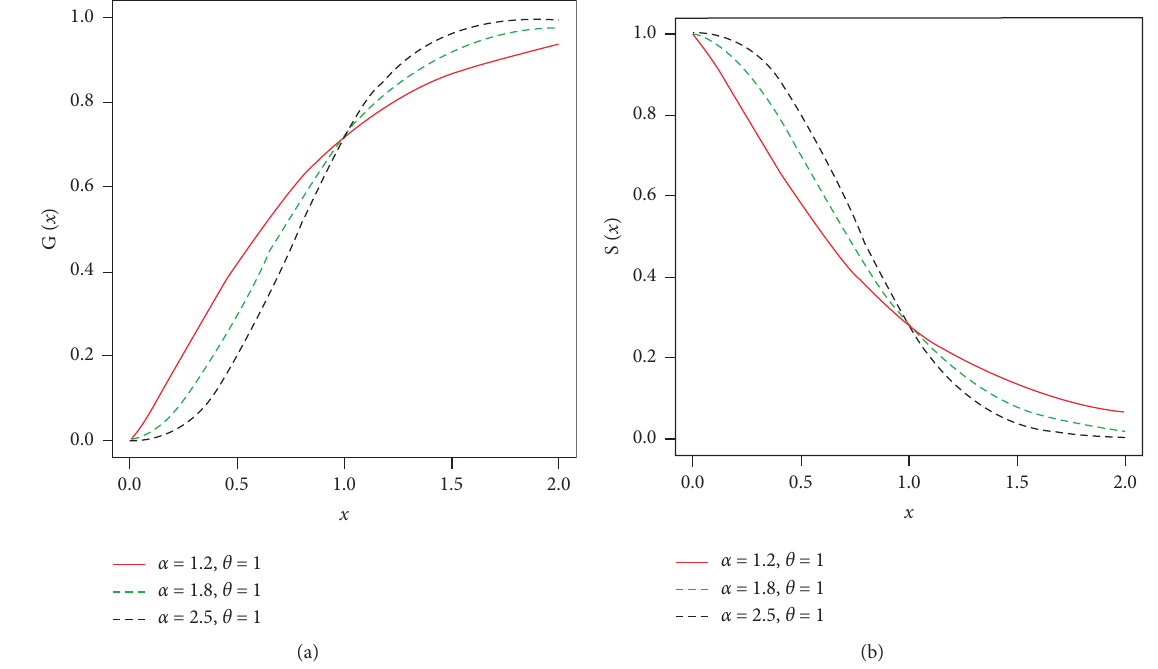
Figure 5: Different plots for the cdf and sf of the NEP-Weibull distribution.